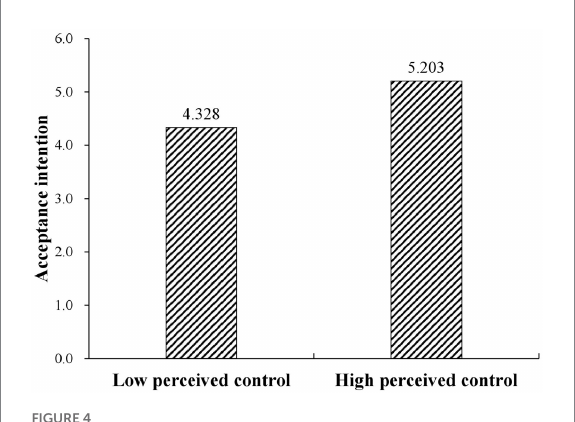
FIGURE 4 Acceptance intention under different levels of perceived control.